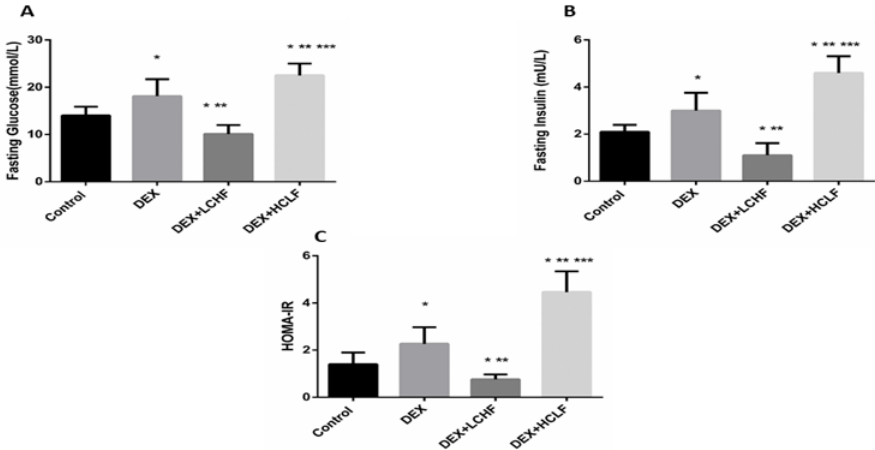
Figure 4. The impact of low-carbohydrate high-fat diet and high-carbohydrate low-fat diet on glucose homeostasis parameters in dexamethasone-treated rats. ( A ): fasting blood glucose; ( B ): fasting blood insulin, and ( C ): HOMA-IR. Data were expressed as mean + S.D. HOMA-IR: homeostasis model assessment of insulin resistance, DEX, DEX + LCHF and DEX + HCLF groups. DEX: rats treated